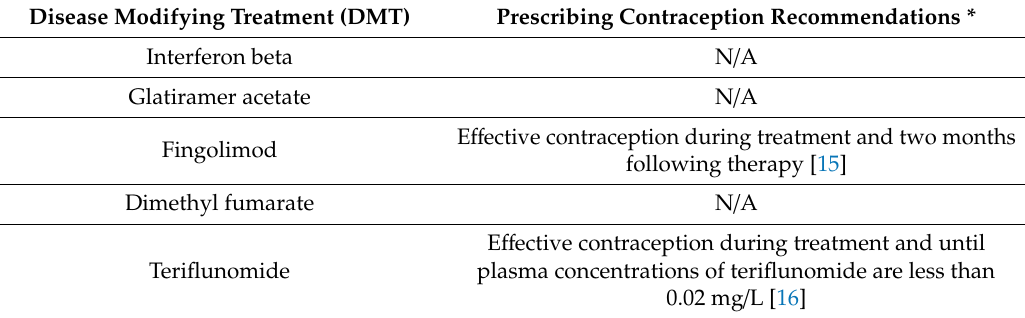
Summary of prescribing contraception recommendations for MS disease-modifying treatments